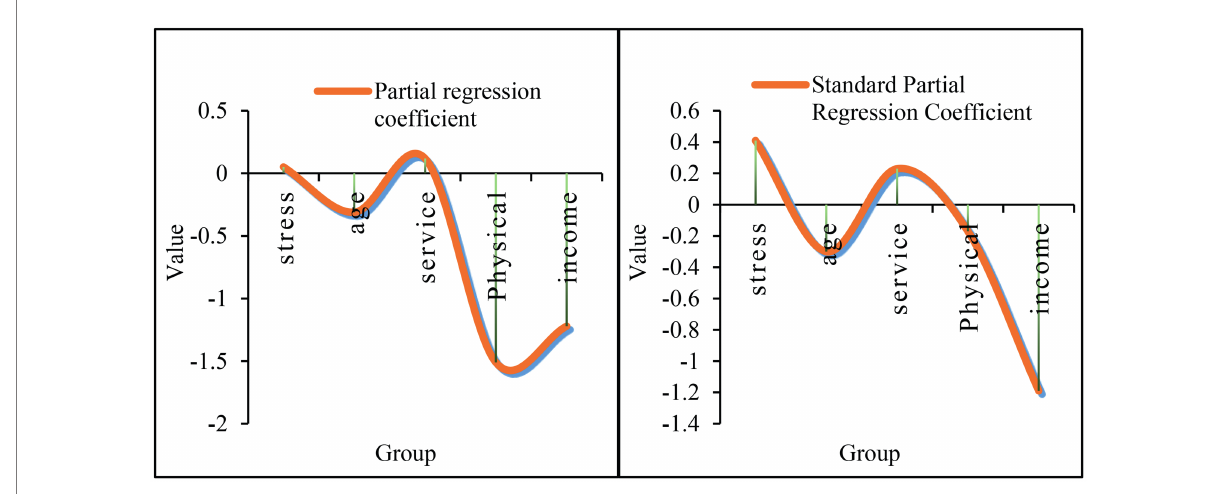
FIGURE 8 Multivariate stepwise regression analysis affecting interpersonal